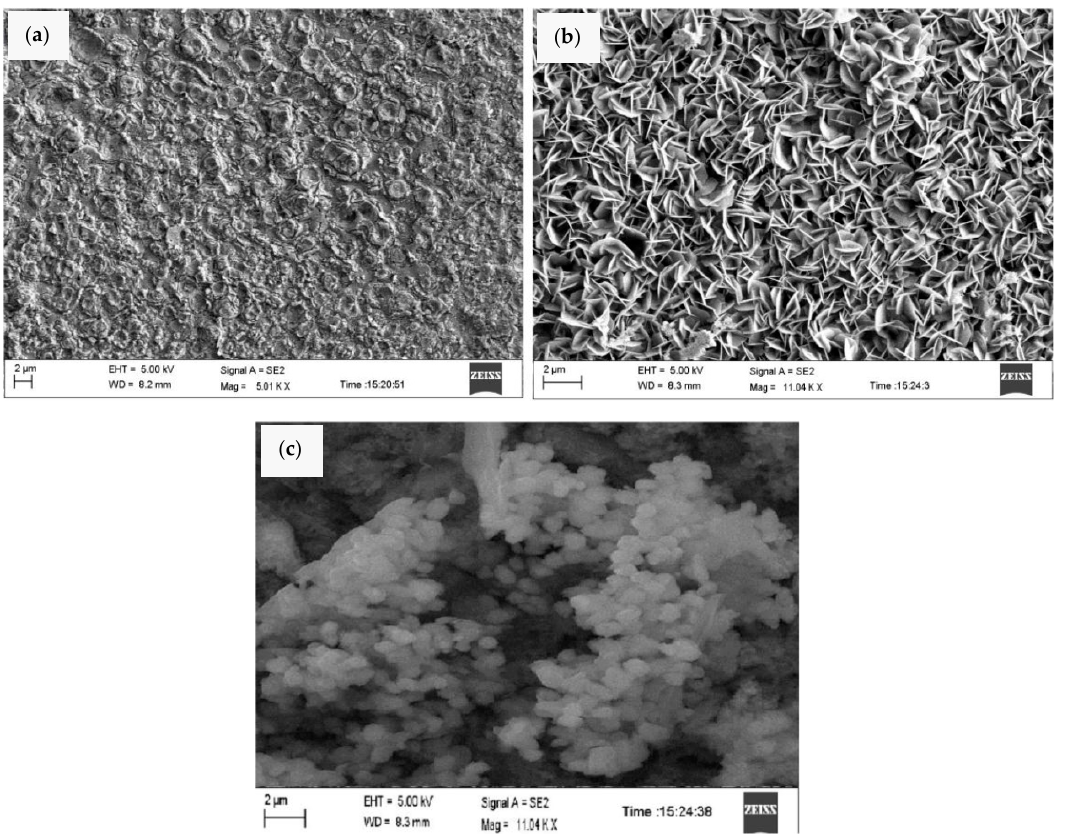
Figure 7. FESEM images of TiO 2 –SiO 2 coating ( a ), TiO 2 –SiO 2 /Chitosan-Lysine coating ( b ) and hydroxyapatite formation on Drug loaded on TiO 2 –SiO 2 /Chitosan-Lysine coating ( c ). (Reprinted with permission from [102] 2018 Elsevier, copyright n. 4557620827469).